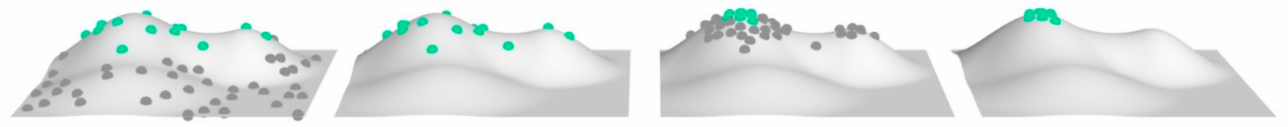
Figure 2. Example of finding the maximum with genetic algorithm. From left to right, the iterative improvement of solution performance can be